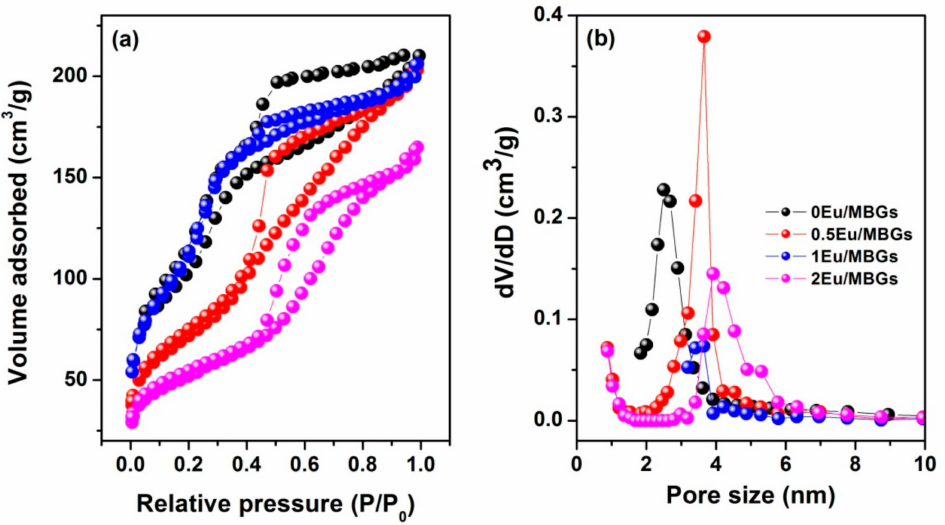
Figure 2. Energy-dispersive X-ray spectroscopy (EDS) mapping for the distribution of Si, P, Ca, and Eu in the 1 Eu/MBGs ( A ), and Eu high resolution X-ray photoelectron spectroscopy (XPS) spectrum of 2 Eu/MBGs ( B ).